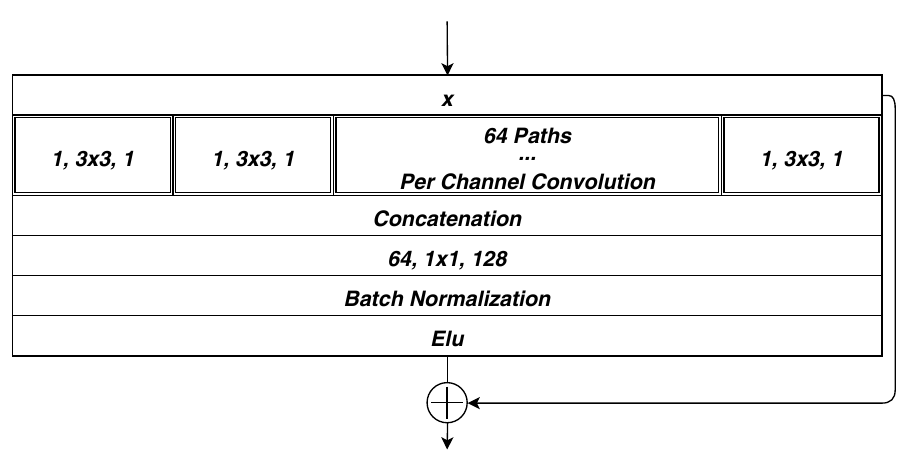
Figure 10. Separable Convolution with Residual Block.